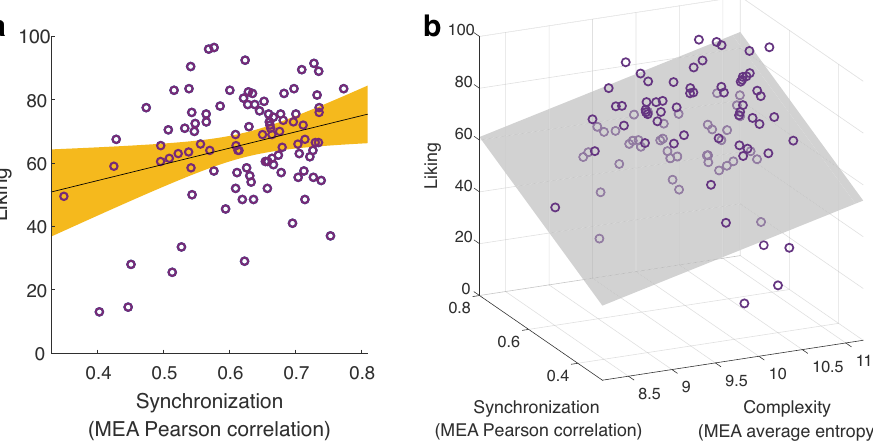
Figure 4. Predicting liking by dyadic movement features. ( a ) Synchronization level of the Z-scored MEA signals significantly predicted liking, F (1, 98) = 8.28, P = 0.005, permuted P = 0.005, R 2 = .08, BF 10 = 7.67. Each circle represents a dyad, the black line is the linear regression line, and the orange area marks the confidence interval around the slope of a regression line. ( b ) Multiple linear regression model including both synchronization and complexity significantly improved the model predictions, this model predicted 14.9% of the variance in liking, R 2 = .149, F (2, 97) = 8.49, P < 0.001, permuted P < 0.001, BF 10 = 66.54. Each circle represents a dyad in the 3D space and the gray plane marks the regression surface that was fitted by the